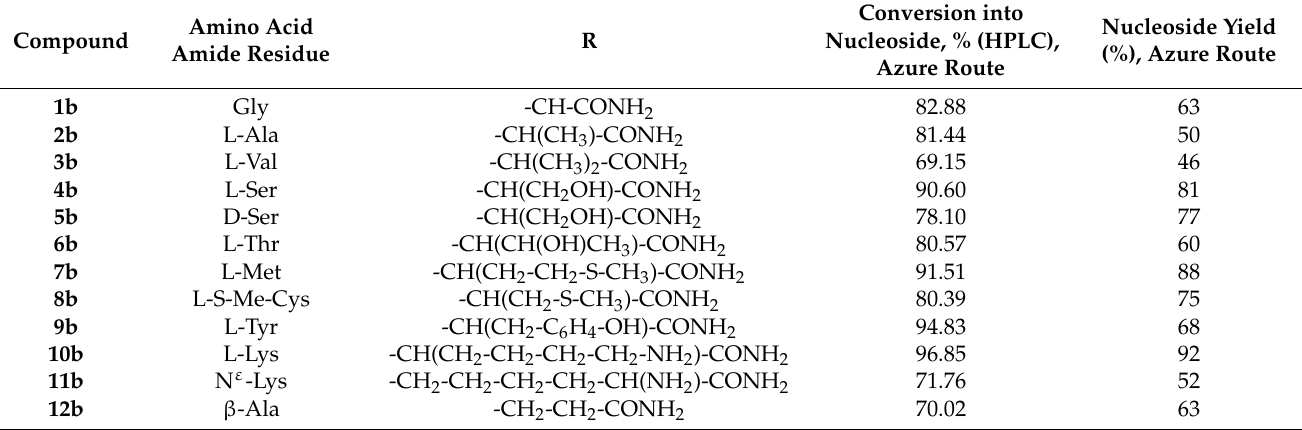
Table 1. Overall conversion and